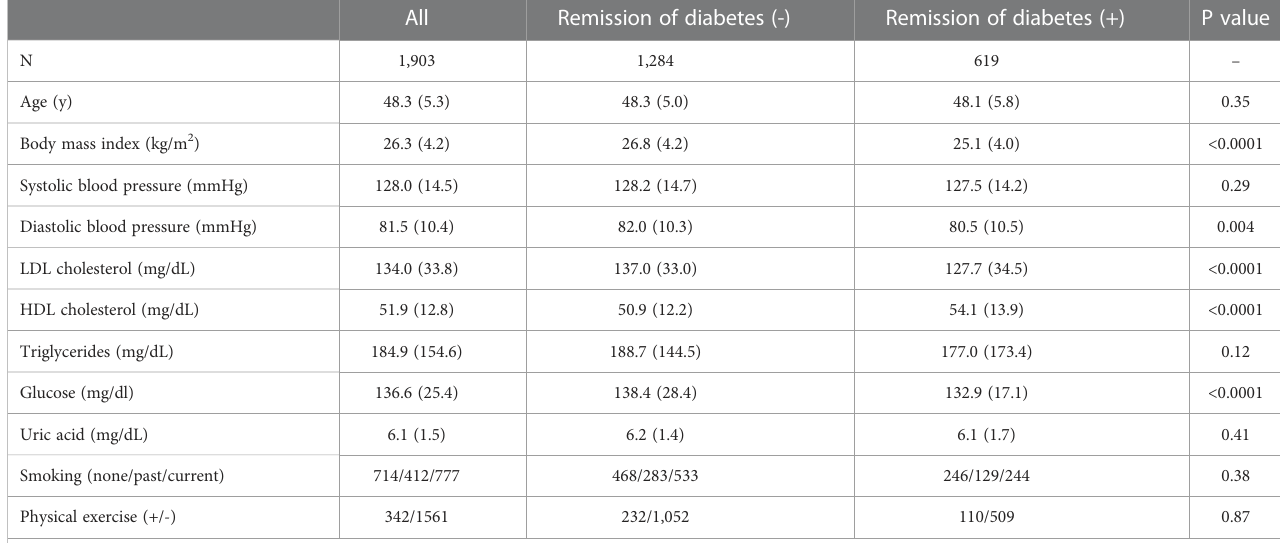
TABLE 1 Characteristics of participants at baseline according to type 2 diabetes